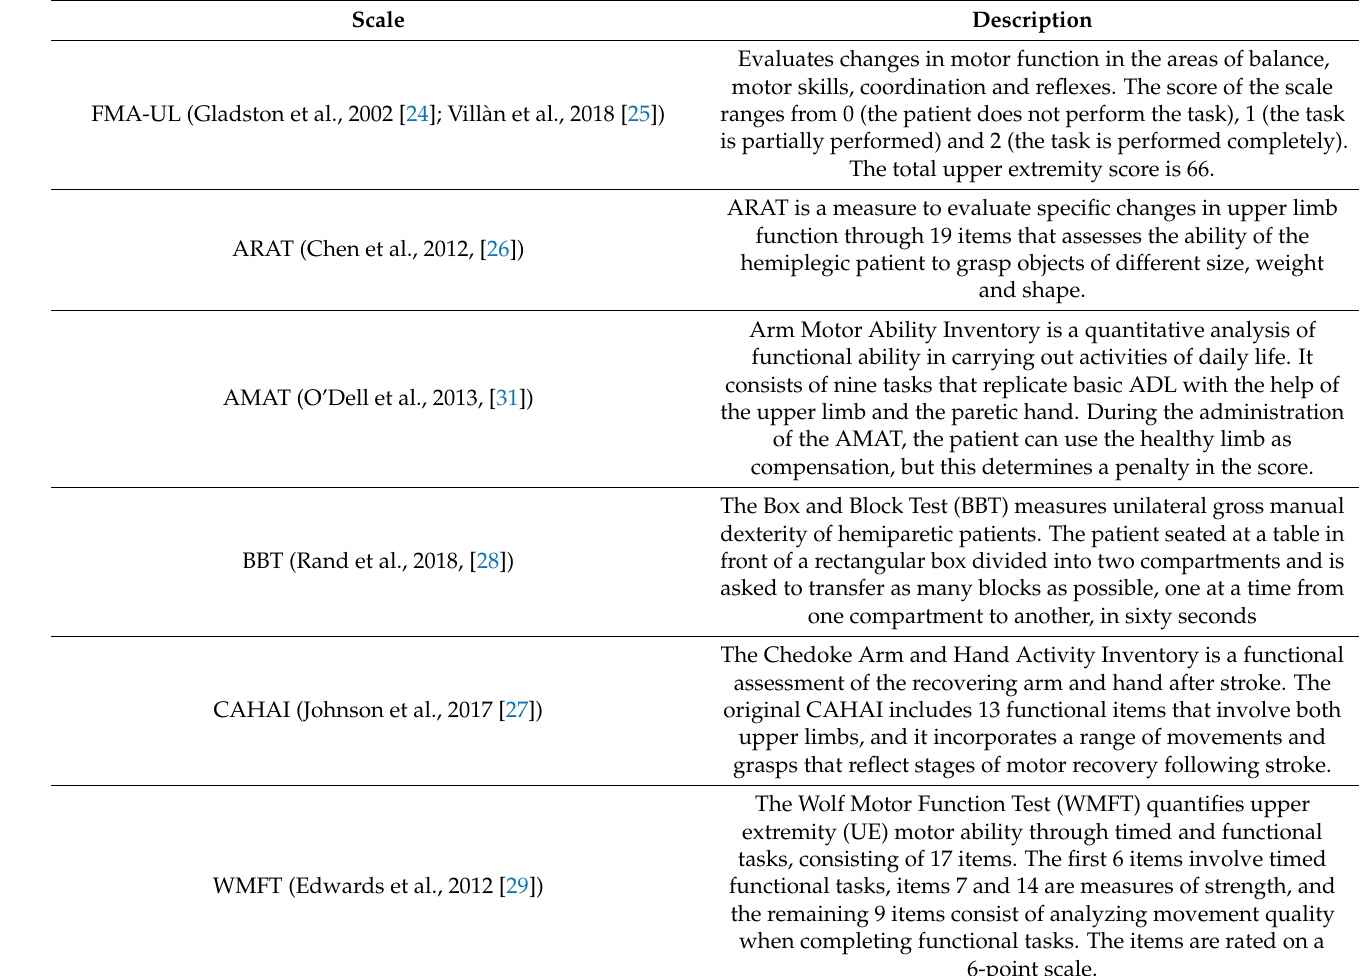
Table 4. Description of upper limb (UL) principles